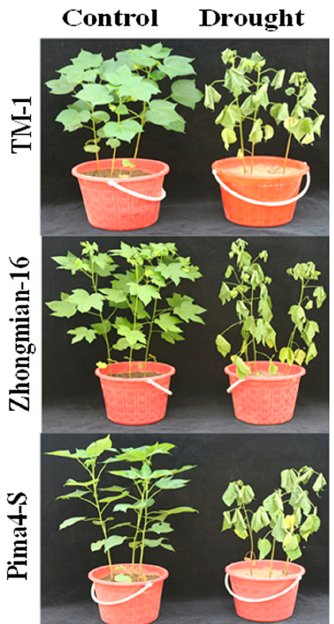
Table 1. Effect of drought stress on the growth parameters of three cotton species.